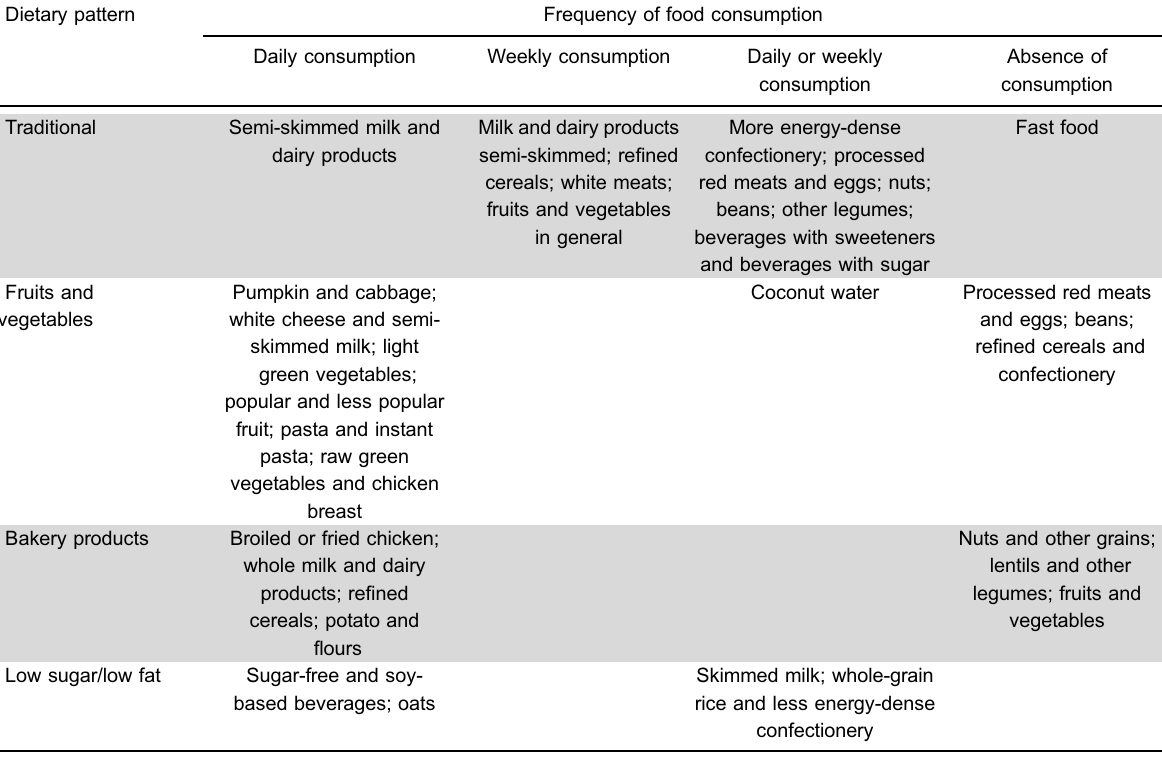
Table 1. Dietary patterns in the ELSA-Brasil cohort. Dietary